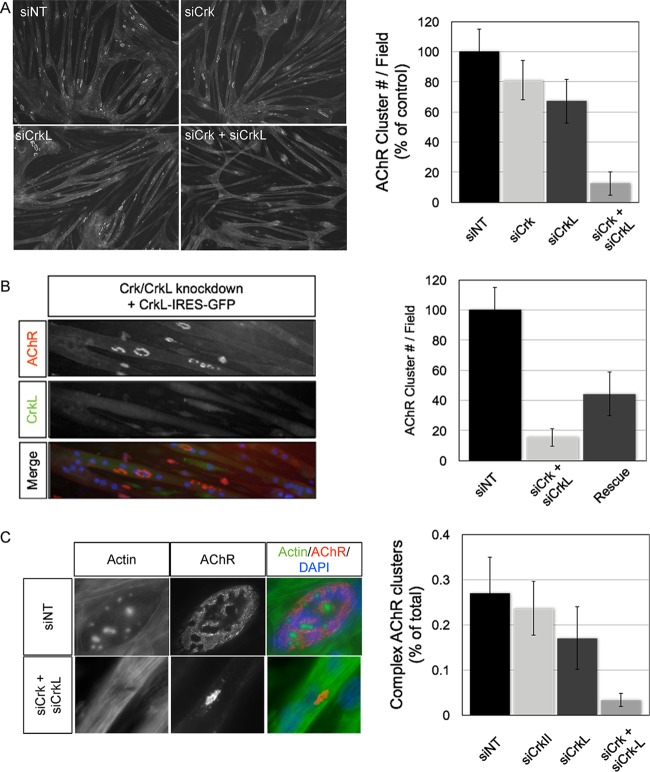
Crk/CrkL RNAi-treated myotubes display AChR clusters that are fewer and lack complexity. (A) Myotubes plated on laminin-111 were transfected with siRNAs directed against a nontargetable control transcript (NT), Crk, CrkL, or both Crk and CrkL. At 48 h posttransfection, myotubes were stained with fluorophore-conjugated bungarotoxin to label AChR aggregates and quantified by intensity threshold gating. In Crk RNAi-treated myotubes, AChR clusters were modestly reduced (∼19%) compared to those in NT-treated myotubes, Similarly, in myotubes treated with CrkL RNAi, AChR aggregates were reduced ∼33% compared to those in NT-treated myotubes. In contrast, myotubes treated with both Crk and CrkL RNAi displayed ∼88% fewer AChR aggregates than NT-treated myotubes (n = 3; means ± standard errors of the means [SEM] are shown; P < 0.05). (B) Myotubes were treated with siRNAs against an NT control or Crk/CrkL as described for panel A and then transfected 4 h later with in vitro-transcribed CrkL mRNA that was resistant to RNAi-mediated degradation. Myotubes transfected with both CrkL mRNA and Crk/CrkL RNAi partially rescued AChR aggregation (∼44% of NT-treated myotubes versus ∼15% for Crk/CrkL siRNA-treated myotubes) (n = 3; means ± SEM are shown; P < 0.05). (C) AChR aggregates that form in Crk/CrkL RNAi-treated myotubes are small and simplified. We scored AChR aggregates for the presence or absence of cortical actin puncta, markers of maturation, and found ∼27% of AChR aggregates from NT-treated treated myotubes harbored actin puncta and that the number was reduced to nearly zero in Crk/CrkL RNAi-treated myotubes (n = 3; means ± SEM are shown).